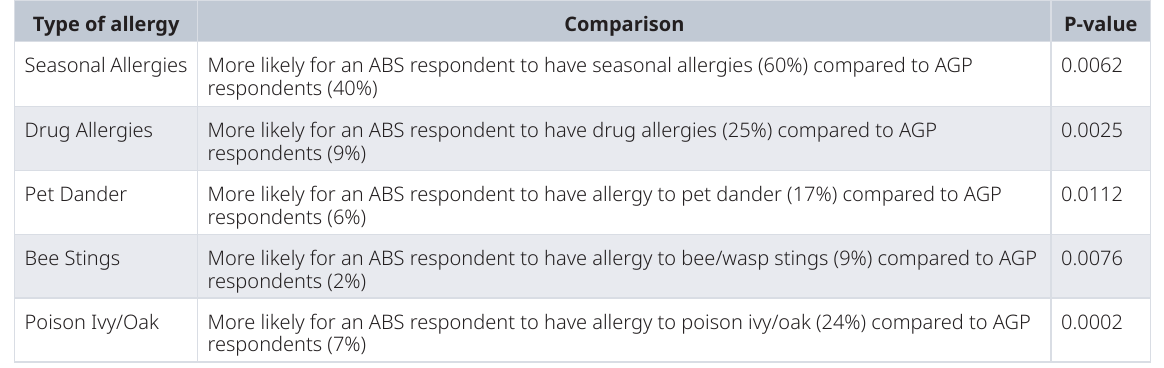
Table 2. Allergies in the Auto-Brewery Syndrome group vs. American Gut Project group. Type of allergy